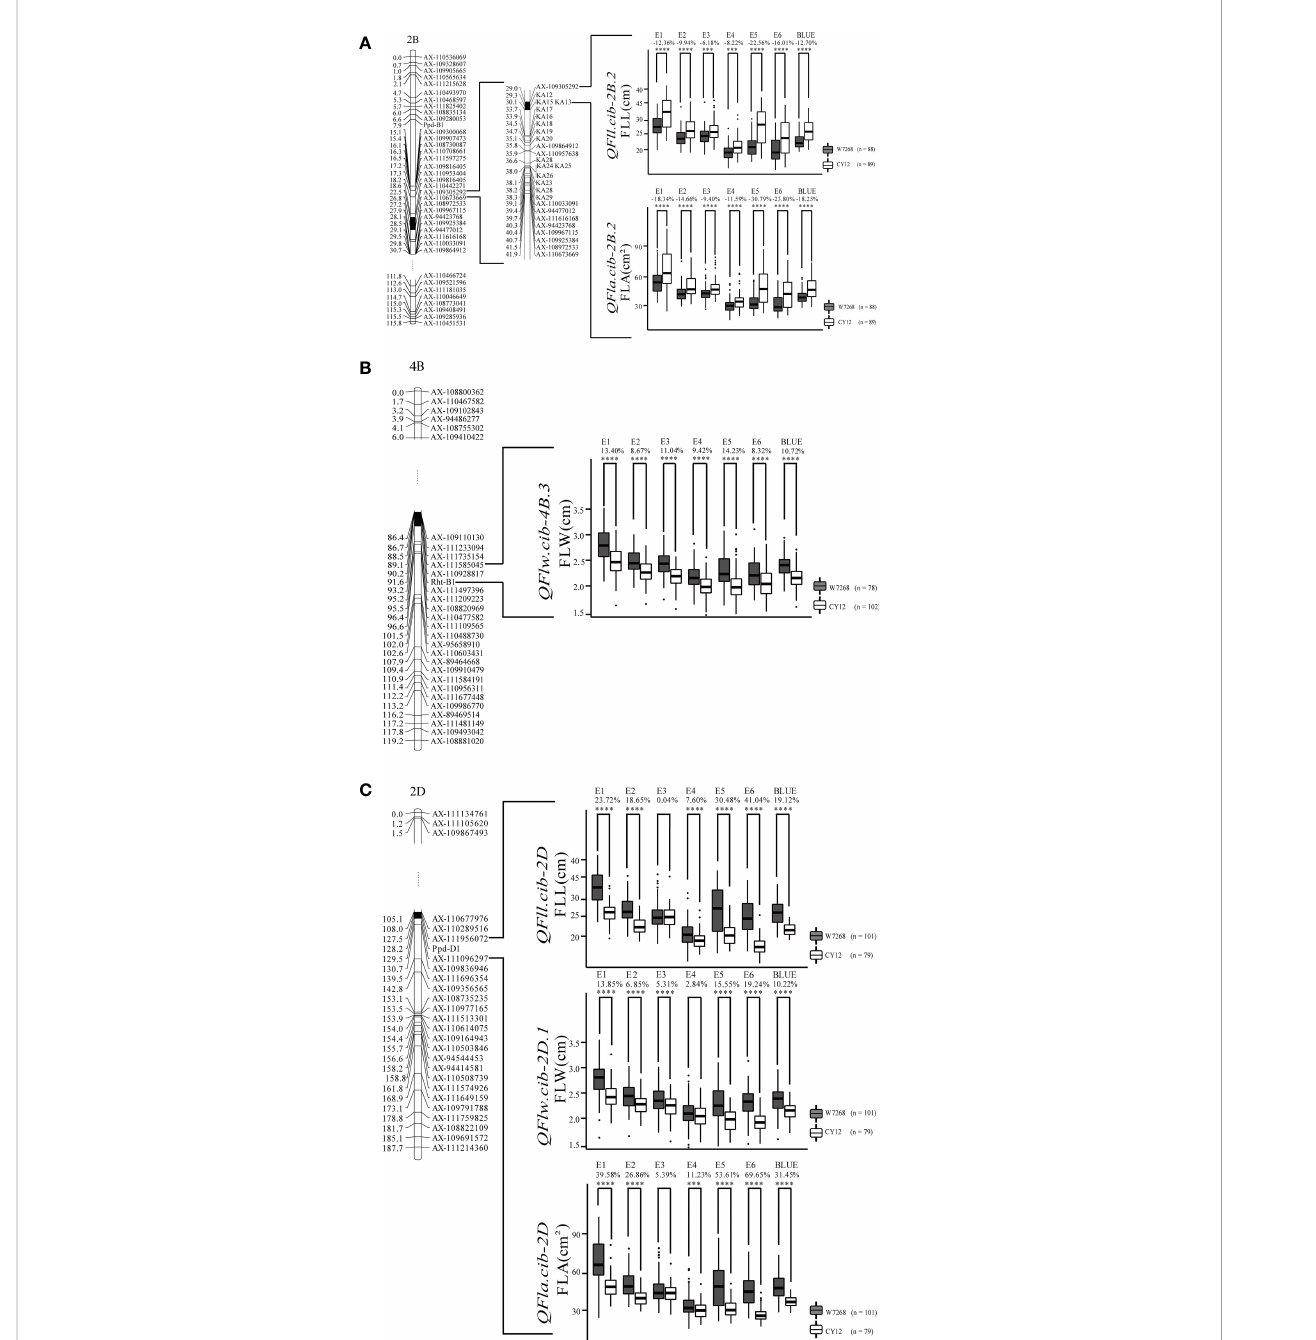
FIGURE 4 Genetic map of major quantitative trait loci (QTL), QFll.cib-2B.2 and QFla.cib.2B.2 (A) , QFlw.cib-4B.3 (B) , QFll.cib-2D, QFlw.cib-2D.1 , and QFla.cib.2D (C) , and their effects on corresponding traits in WC12 population. W7268 and CY12 represent lines with alleles from W7268 and CY12, respectively; ***, and **** represent signi fi cant at P < 0.005, and P < 0.001,